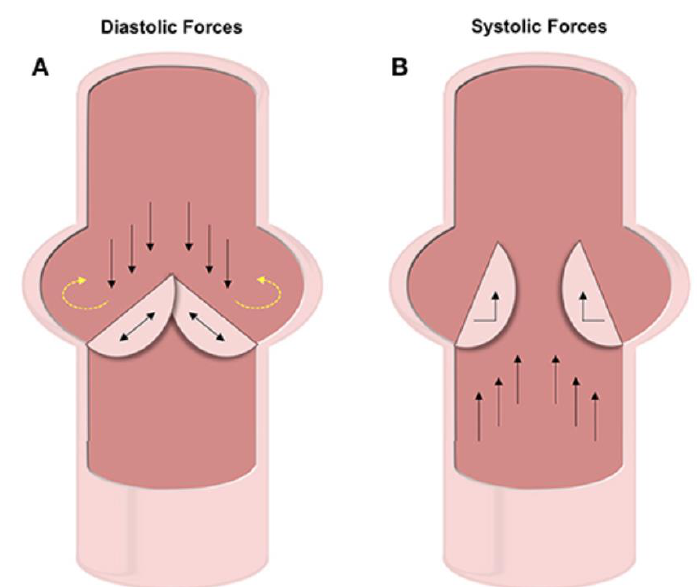
Figure 6. In diastole, as the valves are closed to prevent back flow (black arrows), pressure builds on the valve and circulates onto the wall (yellow arrows). In systole, the valves are forced open by flow propelled by contraction (black arrows) [88].